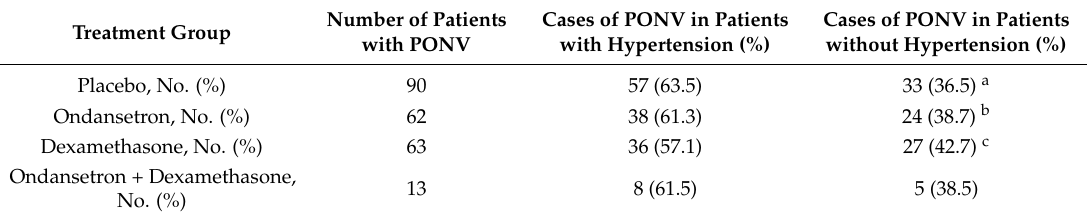
Table 4. Proportion of patients with PONV, with and without arterial hypertension. Treatment